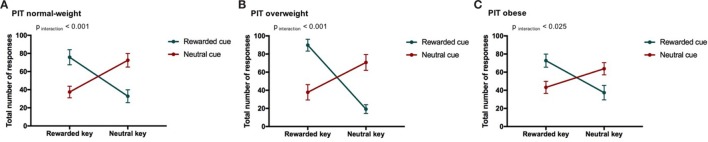
Result from Pavlovian-to-instrumental transfer (PIT) and weight category. Error bars indicate SEM. The rewarded condition is depicted in green and the neutral condition in red. The strength of the PIT effect depends on weight category (normal-weight N = 20, overweight N = 17, obese N = 17, pCONDITION*RESPONSE TYPE*WEIGHT CATEGORY < 0.001). The goal-directed behavior of overweight individuals was most strongly influenced by cues. (A) PIT normal-weight, (B) PIT overweight, and (C) PIT obese.